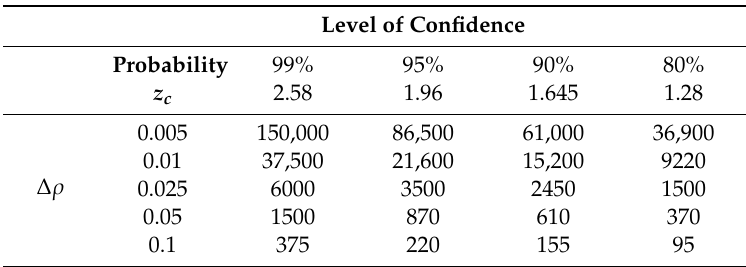
Table 2. Number of Monte Carlo simulations, N s (i.e., sample size), depending on desired accuracy and level of confidence, with r X → Y ≈ 0.5 [41].